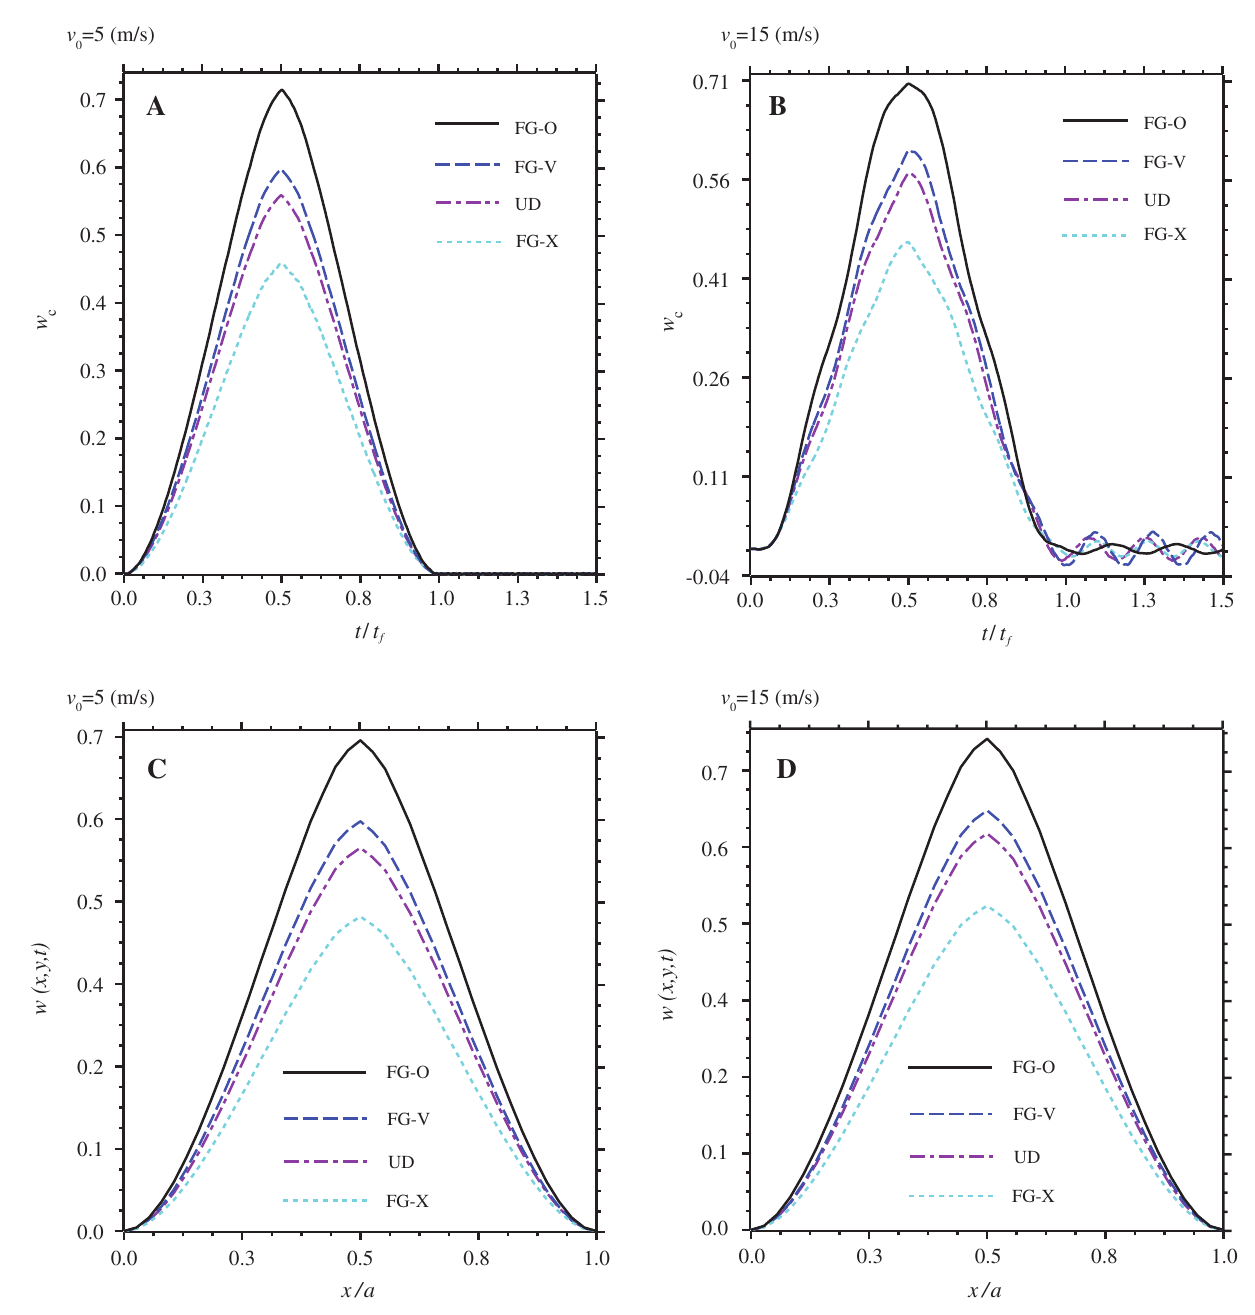
Figure 4 The influence of three different CNT distributions on the dynamic behavior of CNTRC plates with clamped edges: (A, B) the time history of the nondimensional center deflection, (C, D) the profile of the material line y = b /2 at t = 0.5 t The effects of different types of CNT distributions